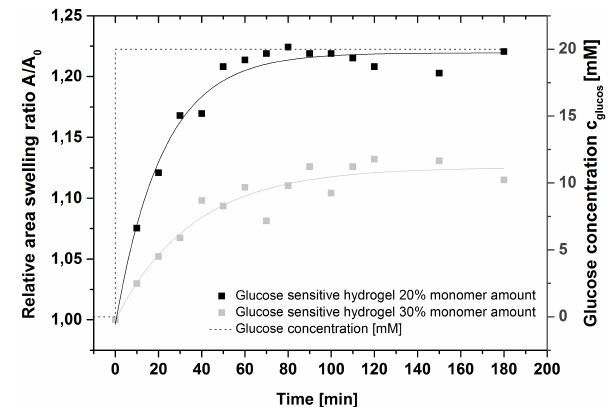
Figure 3. Relative area swelling ratio of the glucose-sensitive hy- drogel with different total monomer amounts of 20 and 30wt% in PBS with 20mM glucose and without glucose.